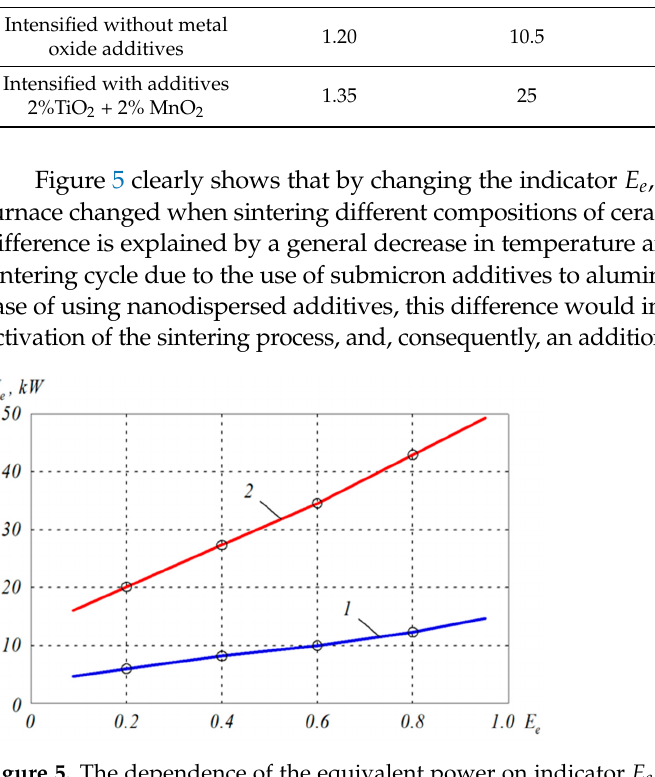
Figure 5. The dependence of the equivalent power on indicator E e during sintering of aluminum oxide ceramics with two percent additives of titanium and manganese dioxides (1) and without additives of other metal oxides (2).